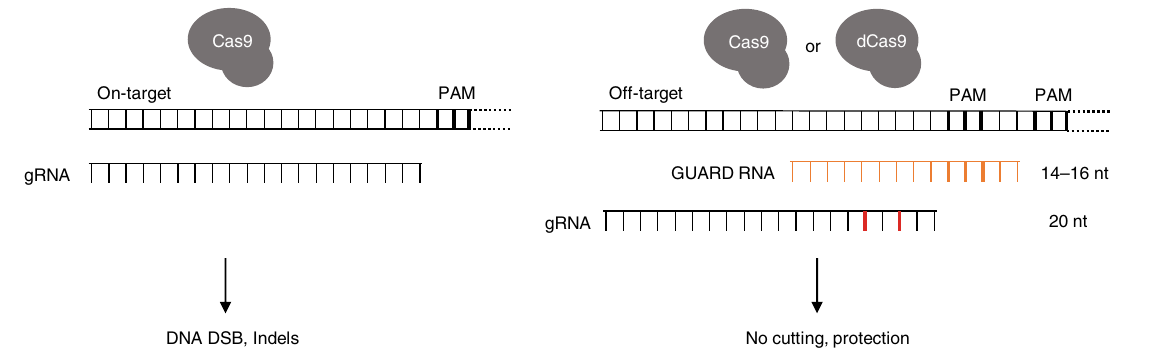
Fig. 1 CRISPR GUARD protection of Cas9 off-target sites. Schematic showing how short gRNAs (orange) forming catalytically inactive complexes with Cas9 can occupy speci fi c off-target sites in the genome and compete with the mismatched nuclease competent gRNA (black), thereby providing protection from Cas9-mediated DNA cleavage. Mismatches in the gRNA are shown in red. RNA bases overlapping the gRNA PAM are shown in